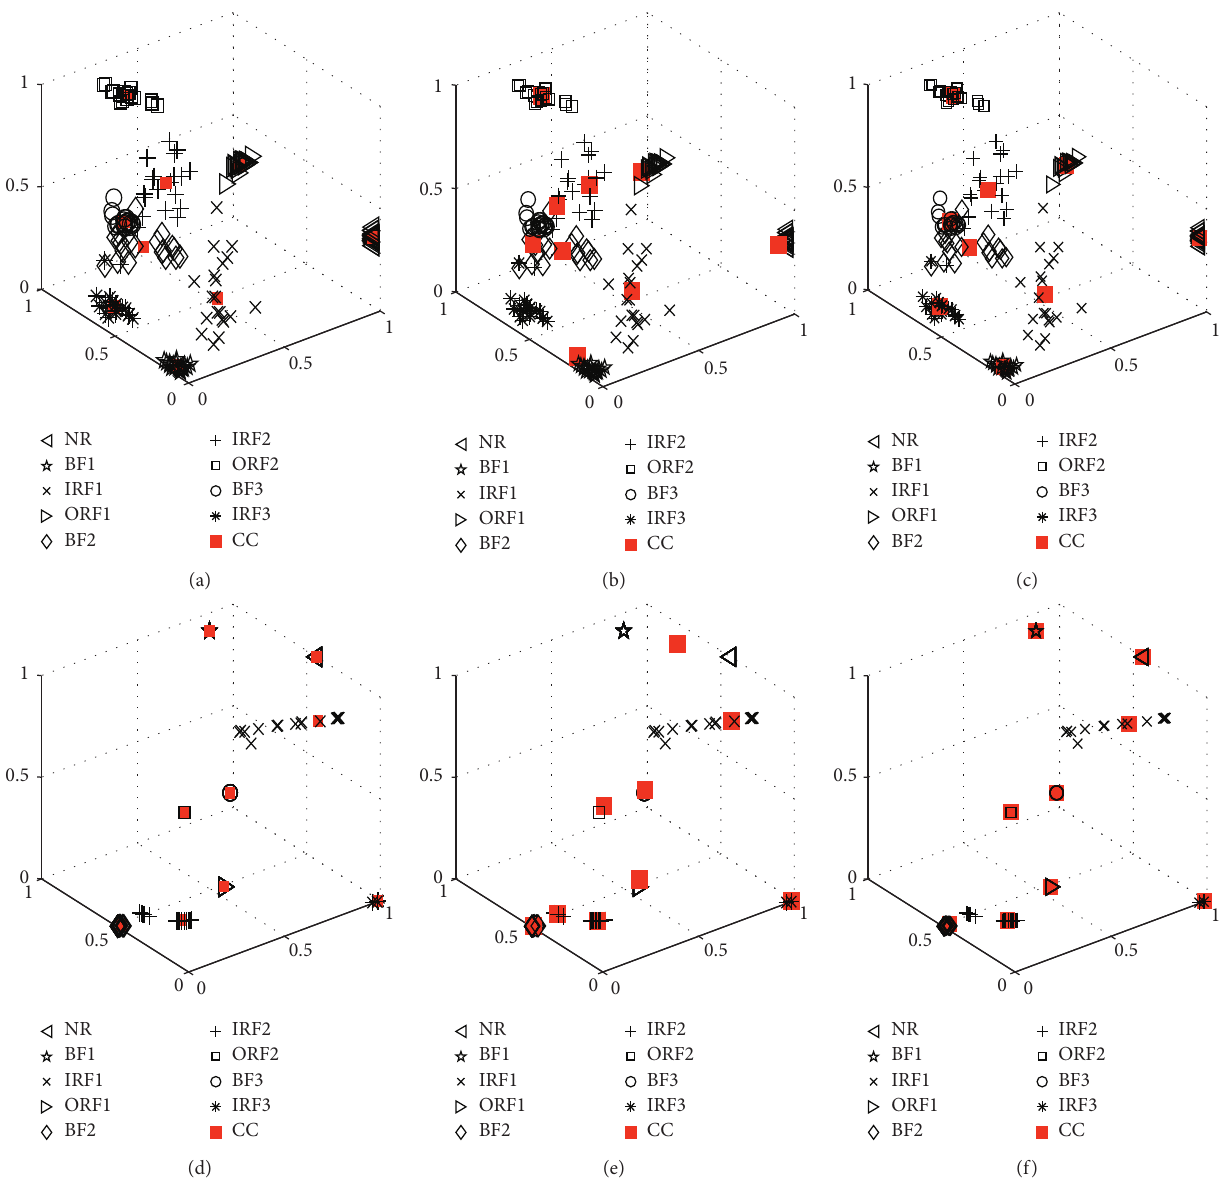
Figure 17: The 3-dimensional clustering for the testing dataset B by using an SAE/SDAE with FCM/GK/GG. (a) SAE-FCM-B. (b) SAE-GK- Table 7: The error classification accuracy through various models (the testing